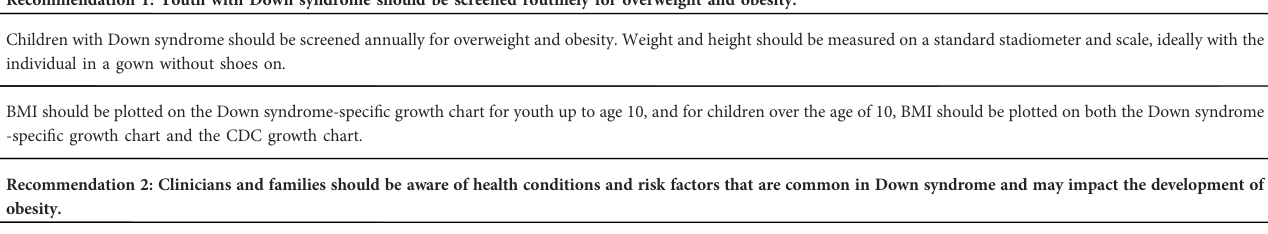
Recommendation 3: Clinicians should screen for feeding dif fi culties in all youth with Down